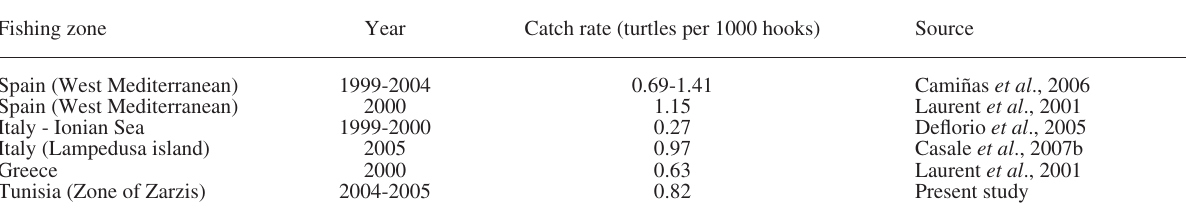
Table 1. – Comparison of turtle catch rates from various longline fisheries in the mediterranean. Fishing